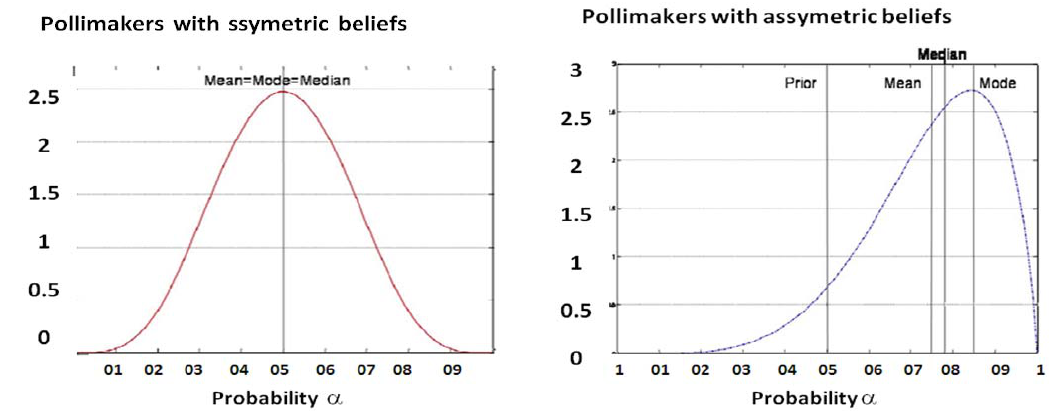
Fig. 2. Policy-makers’ beliefs on the probability